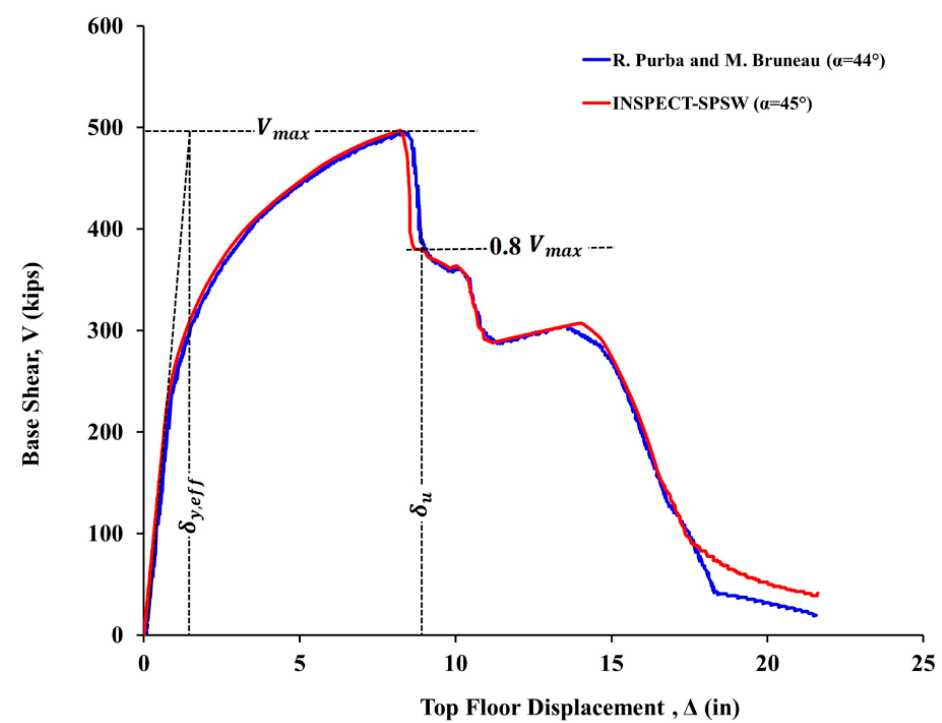
Figure 8. Comparison of monotonic pushover analysis curves published by R. Purba and M. Bruneau [30] and solved by INSPECT-SPSW for the SW320 model.